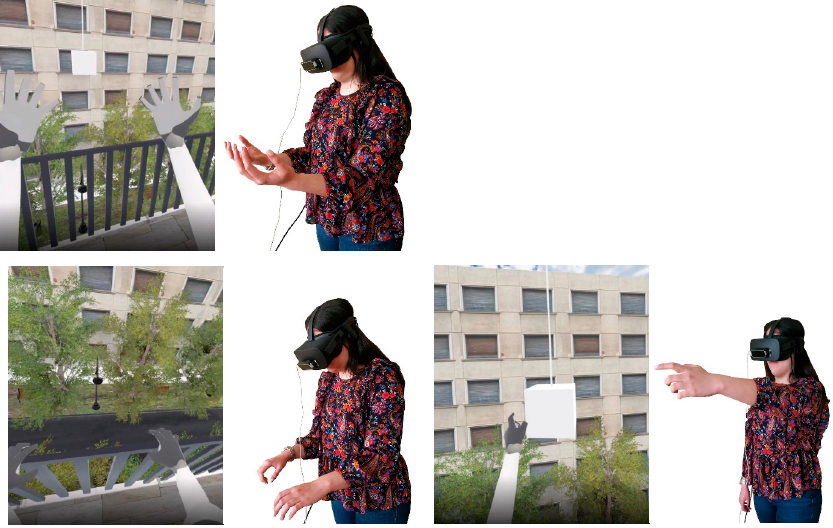
Figure 10. Demonstration of the VR-MC simulation during the procedure.